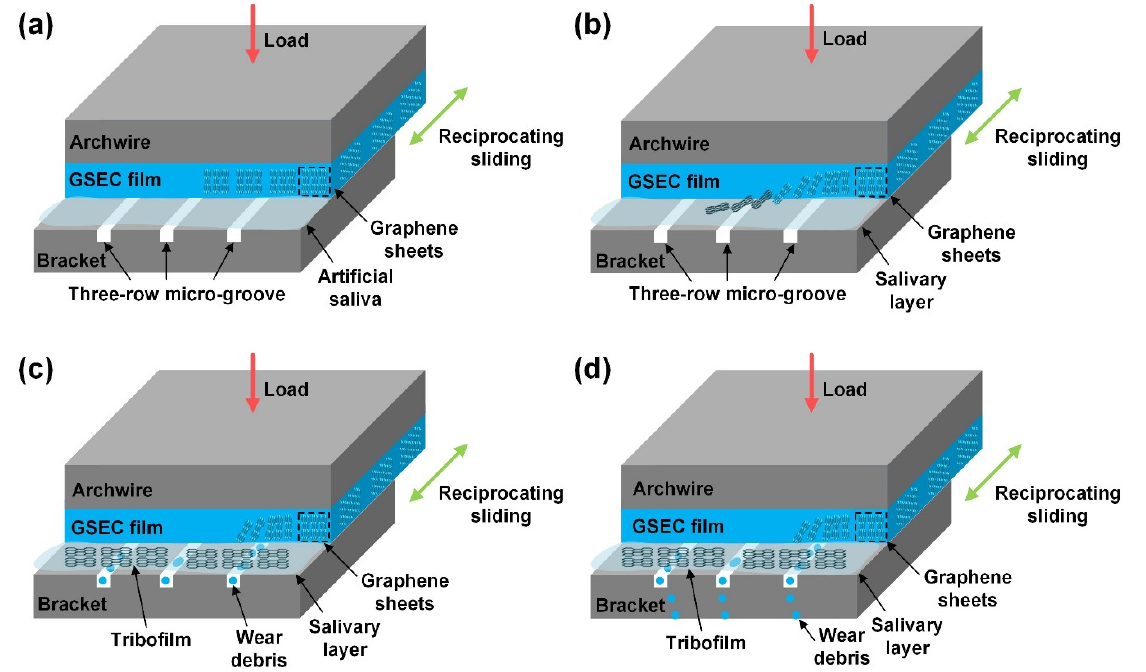
Figure 9. The low friction and low wear mechanisms of the GSEC film (+50 V and 80 min) coated stainless steel archwires running against three-row micro-groove textured stainless steel brackets in an artificial saliva environment. ( a ) Initial state of the contact combination, ( b ) stable low friction with the formation of graphene-rich tribofilm and salivary adsorbed layer, ( c ) accumulation of wear debris detached from the GSEC film with micro-groove, and ( d ) flow out of wear debris with artificial saliva from the micro-groove.